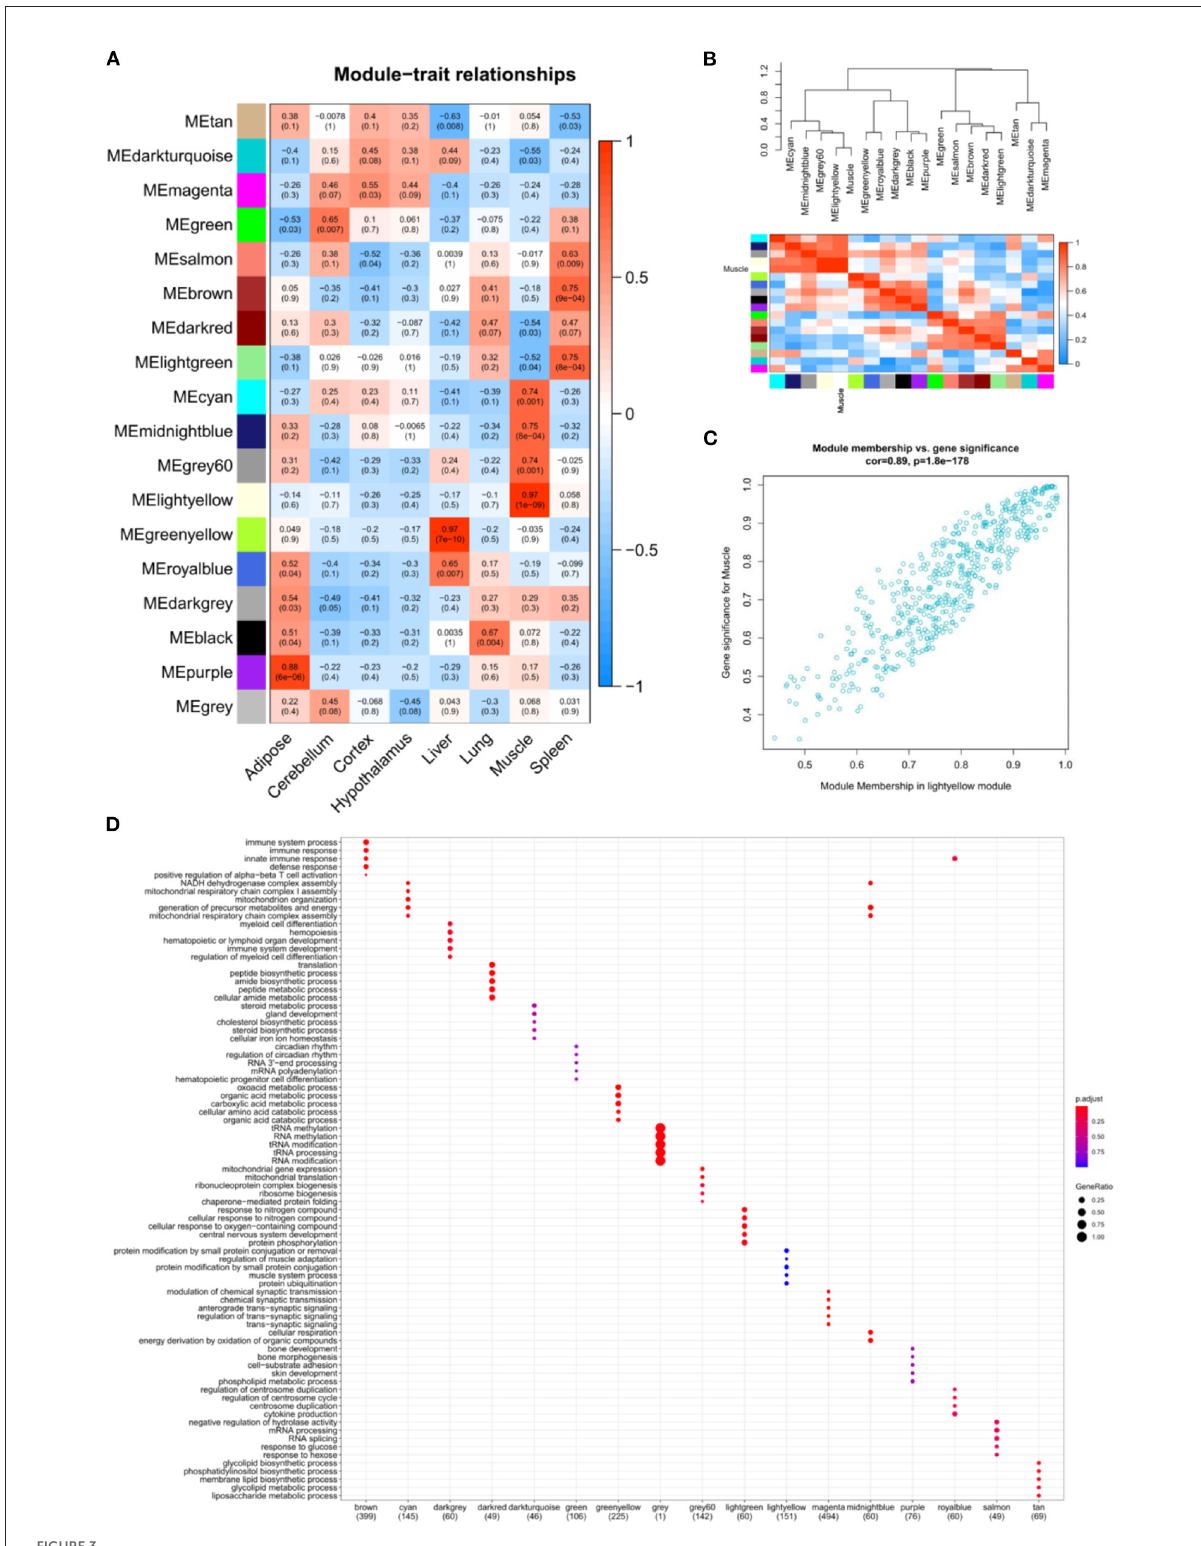
FIGURE3 The relation analysis between modules and samples. (A) Heatmap of the module-sample correlation. Significance ( P -value) was marked in parentheses. The color bar represented the magnitude of the correlation. Red: positive-correlation, blue: negative-correlation; (B) The adjacency heatmap of eigengene, including the module clustering tree (top) and the corresponding module clustering heatmap (below). The color bar represented the magnitude of the correlation. Red: positive-correlation, blue: negative-correlation; (C) The scatterplot of GS and MM in MElightyellow module; (D) The top 5 significant GO-BP analysis form each module